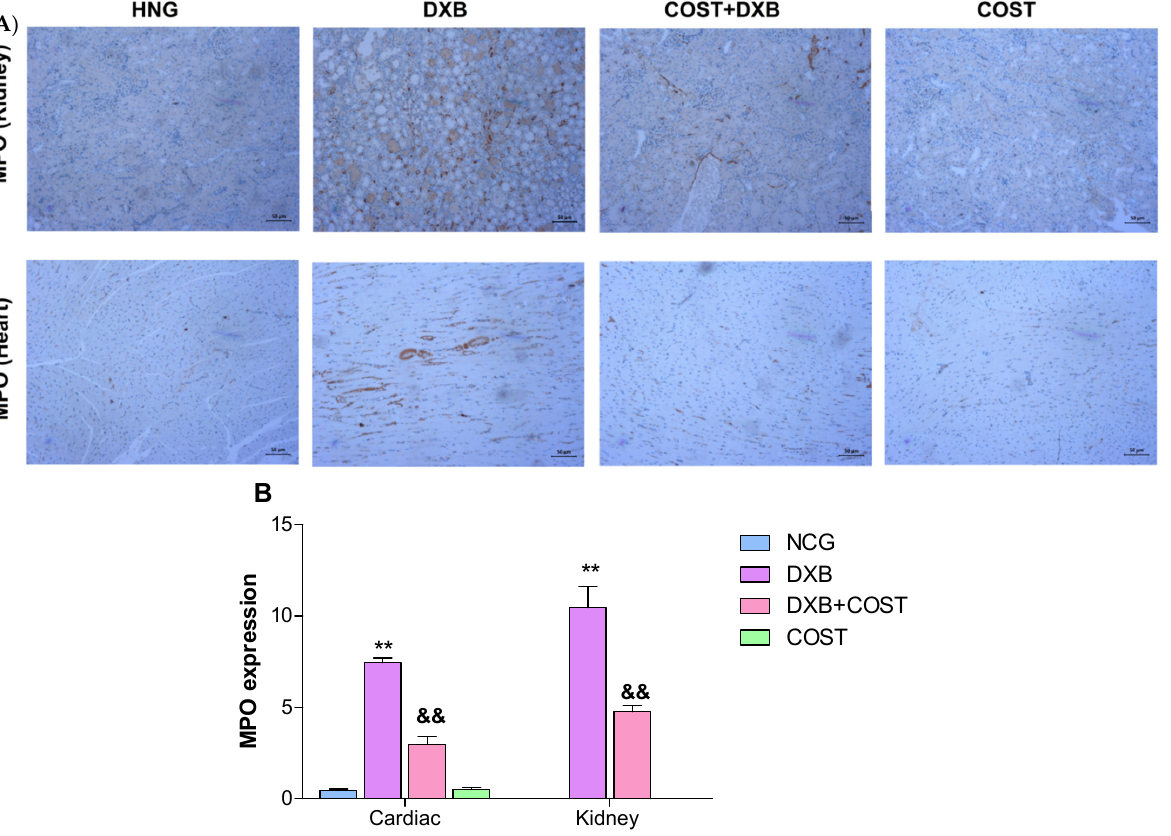
Figure 7. ( A ): Photomicrography of kidney and heart tissues showing expression of p53 in all ex- perimental groups, ( B ): quantification of p53 immunohistochemical expression in kidney and heart tissues. ** Statistically significant ( p < 0.01) compared with NCG and COST groups. && Statistically significant ( p < 0.01) compared with DXB group.